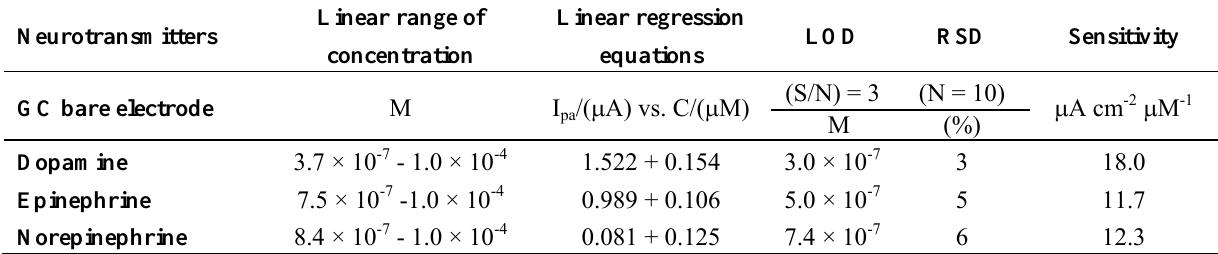
Table 2 . Analytical parameters for GC bare electrodes toward dopamine, epinephrine, and norepinephrine. Differential Pulse Voltammetric calibrations in 0.1 M phosphate buffer, pH 7.4 (20 mL) + 0.01mM